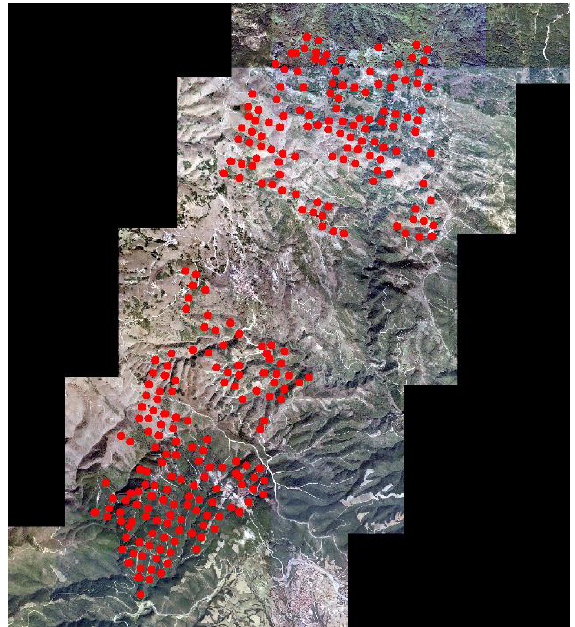
Figure 3. The VHR orthophotos used in this study superimposed by the plot surfaces of the field data are presented. © Greek National Cadastre and Mapping Agency, Copyright 2007-2009.